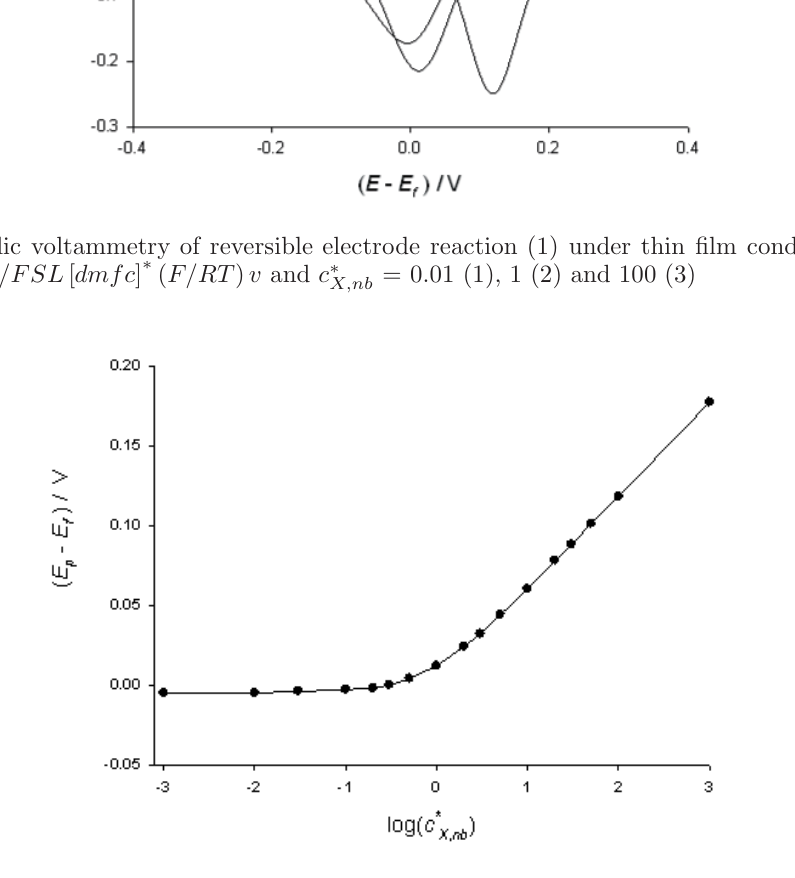
Fig. 2 Dependence of peak potentials of cyclic voltammograms of reversible reaction (1) on the logarithm of dimensionless initial concentration of anion X − in the